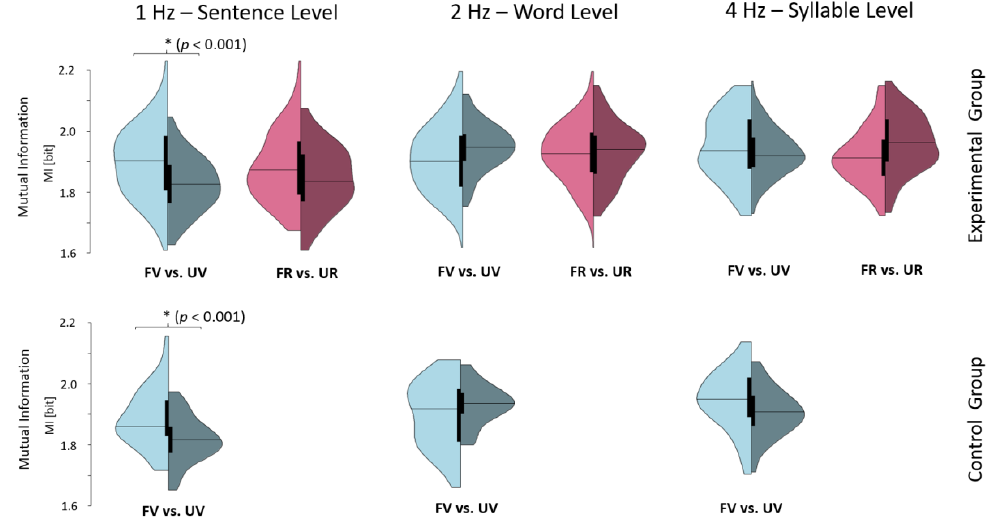
Figure 3. Speech-envelope amplitude coupling with EEG. The horizontal line indicates the mean mutual information (in Bit units) for a spatial cluster around the temporal cortices (cf.